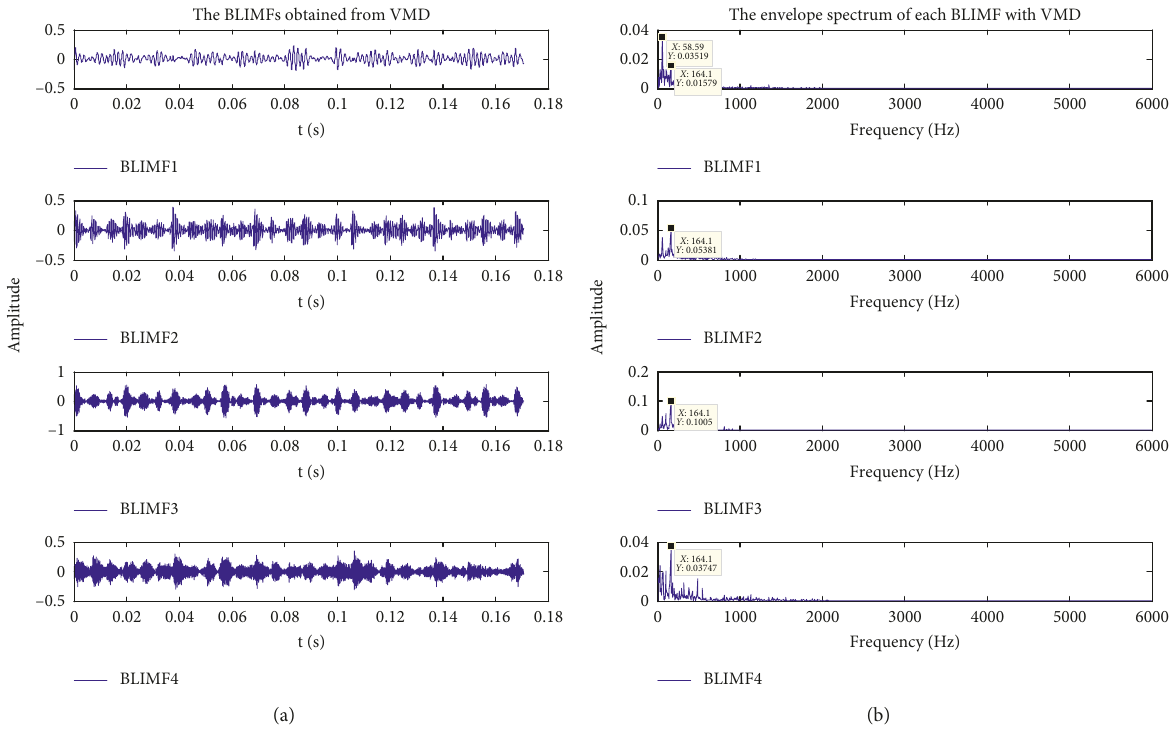
F IGURE 5: Signal decomposition diagram (VMD): (a) the BLIMF components; (b) the envelope spectrum of each BLIMF.